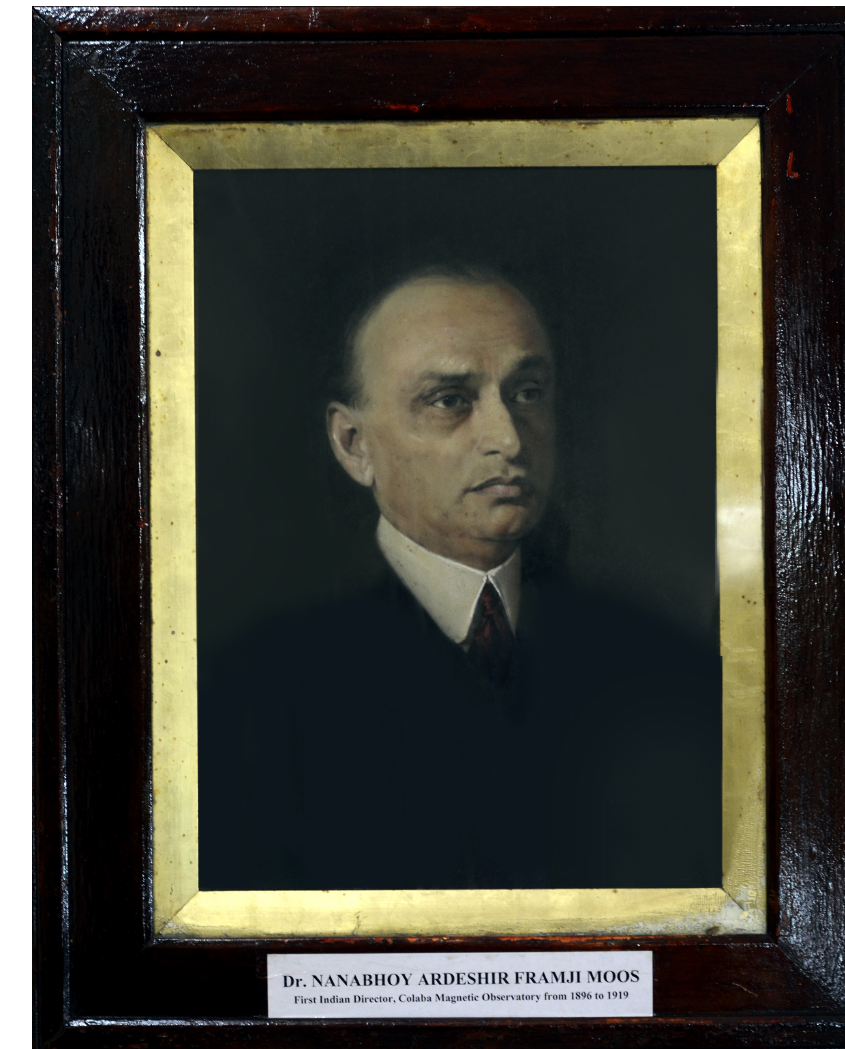
Figure 16. Photo of Dr. Nanabhoy Ardeshir Framji Moos, the first Indian director within the realm of colonialists, who held his own and even surpassed some of the best European minds of his time (photo courtesy of Colaba–Alibag